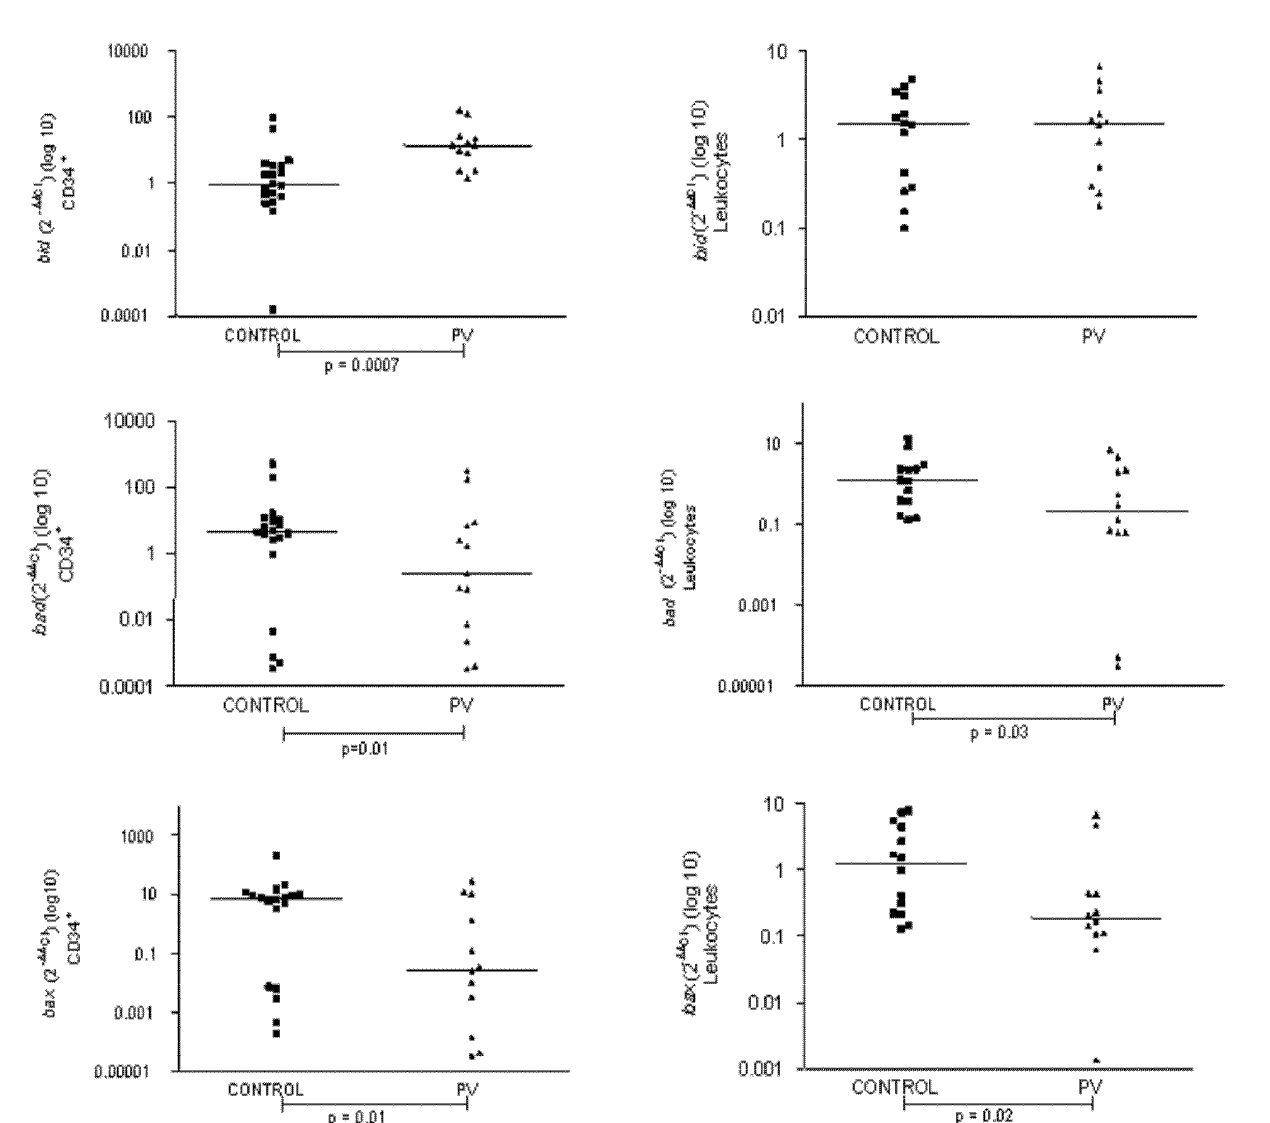
FIGURE 2 - mRNA levels of Bid, Bax and Bad proapoptotic molecules in CD34 + HSC and leukocytes from PV patients and controls. Βeta-actin gene was used as endogenous control. Gene relative expressions were detected by real time PCR and results were given as 2 -∆∆Ct . The horizontal lines represent the median of gene expression in each group analyzed. PV patients’ CD34 + HSC showed Bid elevated expression (median=14.4, p=0.002) in relation to normal individuals. The Bax (median= 6.76, p=0.010) and Bad (0.24, p=0.010) expression were reduced in patients’ CD34 + HSC. The Bad (0.2; p=0.030) and Bax (0.19; p=0.020) levels were also decreased in PV patient leukocytes compared with